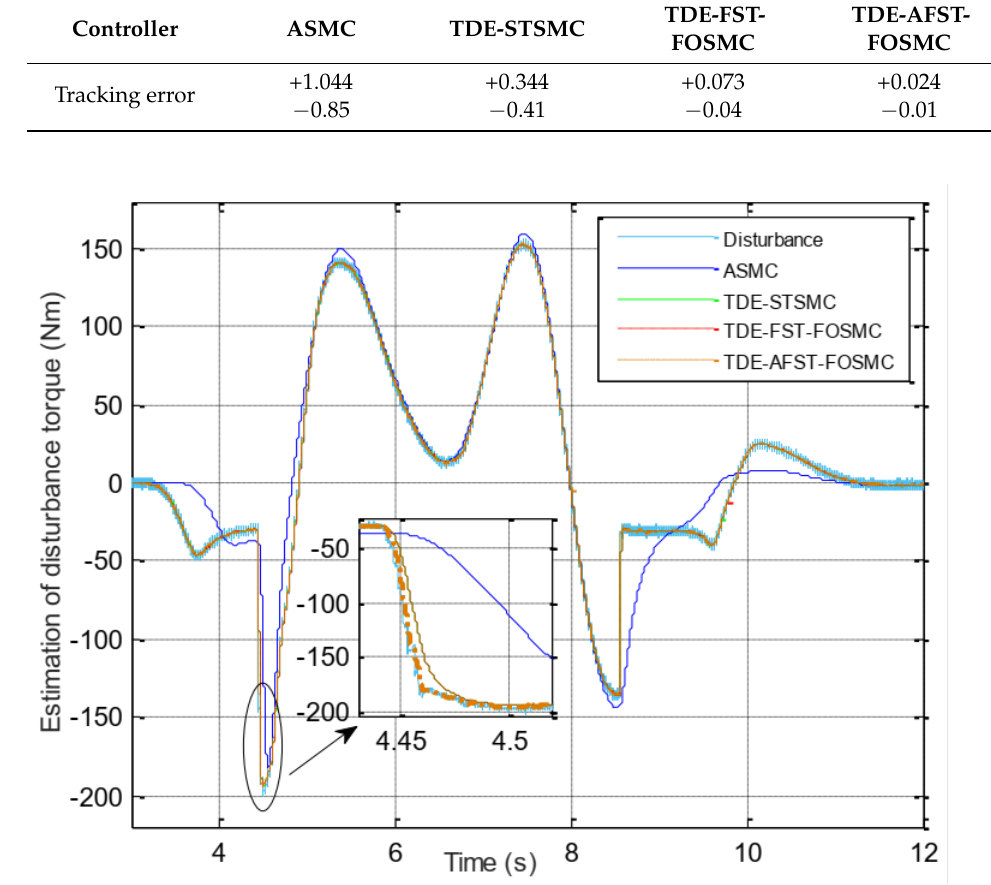
Figure 11. Estimation performance of disturbance